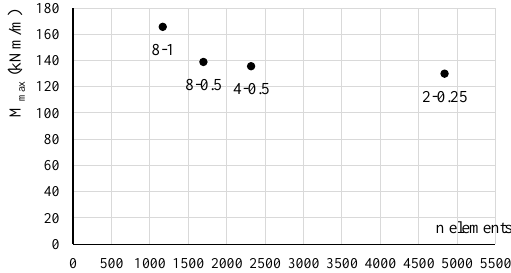
Figure 2. Evolution of lining moment as a function of mesh